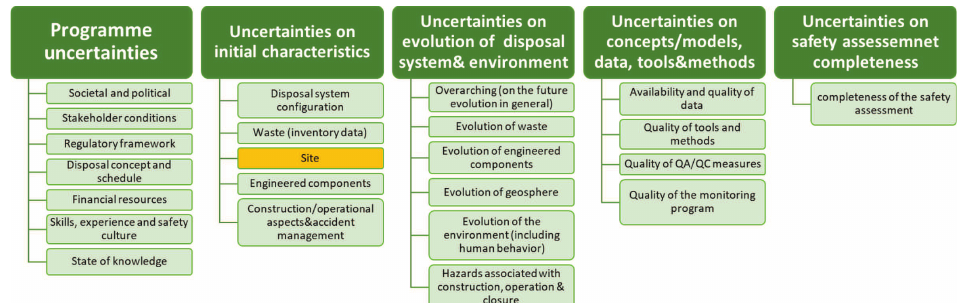
Fig. 2. Multi-level classification of uncertainties into different types of uncertainty and each type into different topical groups that various actors consider potentially relevant for the safety case. The third level (see Fig. 3) represents uncertainties specific to each topical group.